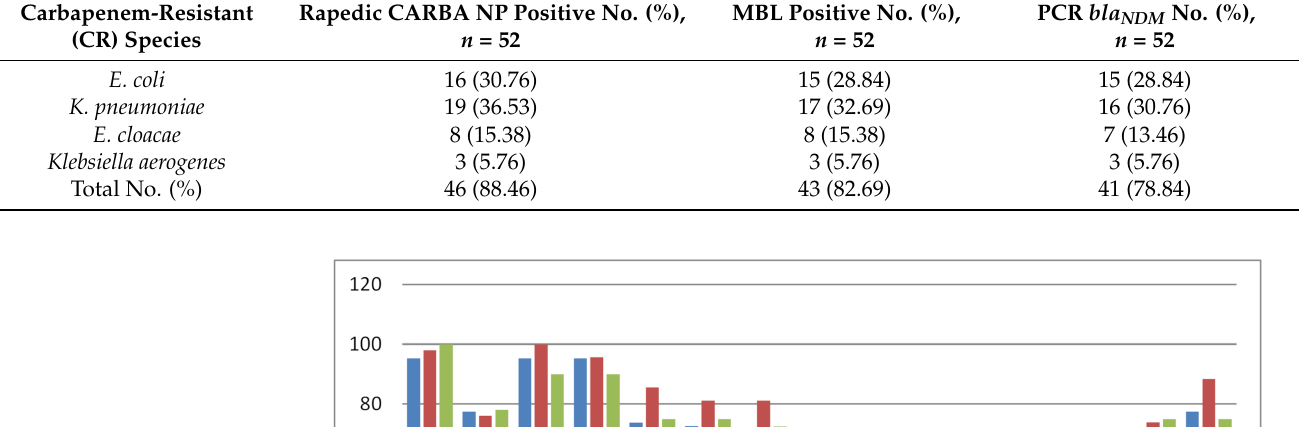
Table 2. Phenotypic detection of carbapenemases by Rapedic CARBA NP test, MBL detection by EDTA synergy with carbapenems (double disc diffusion test, (DDST)) and carbapenemases by PCR in CRE isolates ( n = 52).